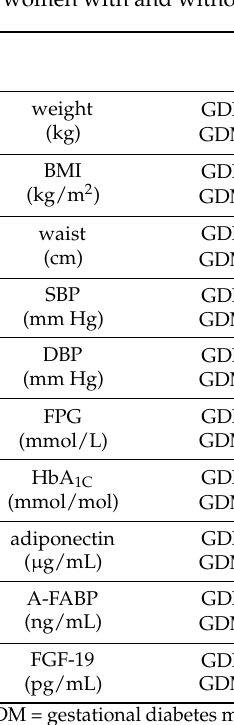
with GDM only in the second trimester while it did not differ between the groups in the third trimester (GDM+ vs. GDM − ). No significant changes in FGF-19 were detected in both groups during pregnancy. FGF-19 levels did not significantly differ between the groups (GDM+ vs. GDM − ) throughout the